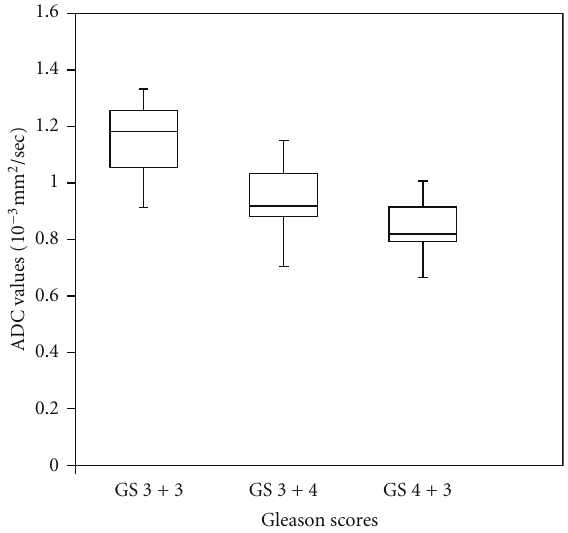
Figure 2: Box-Whisker plots of ADC values of Gleason score (GS) 3 + 3, (GS) 3 + 4 and (GS) 4 + 3 patients. The center horizontal line indicates the median.